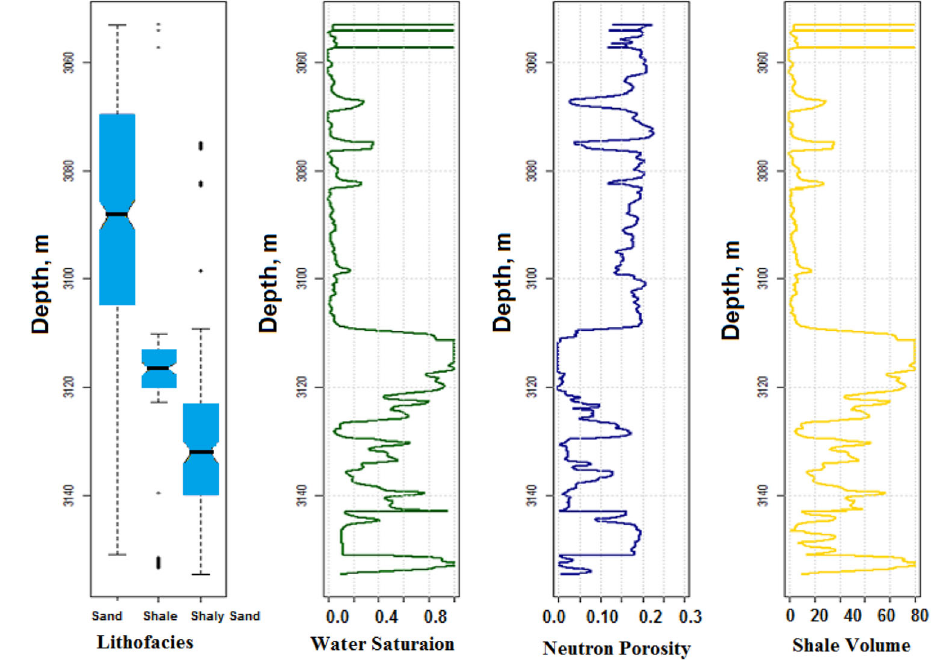
Fig. 3 Distribution of discrete lithofacies and well log interpretations. The measured lithofacies from core data analyses include sand, shale, and shaly sand only. The available well log